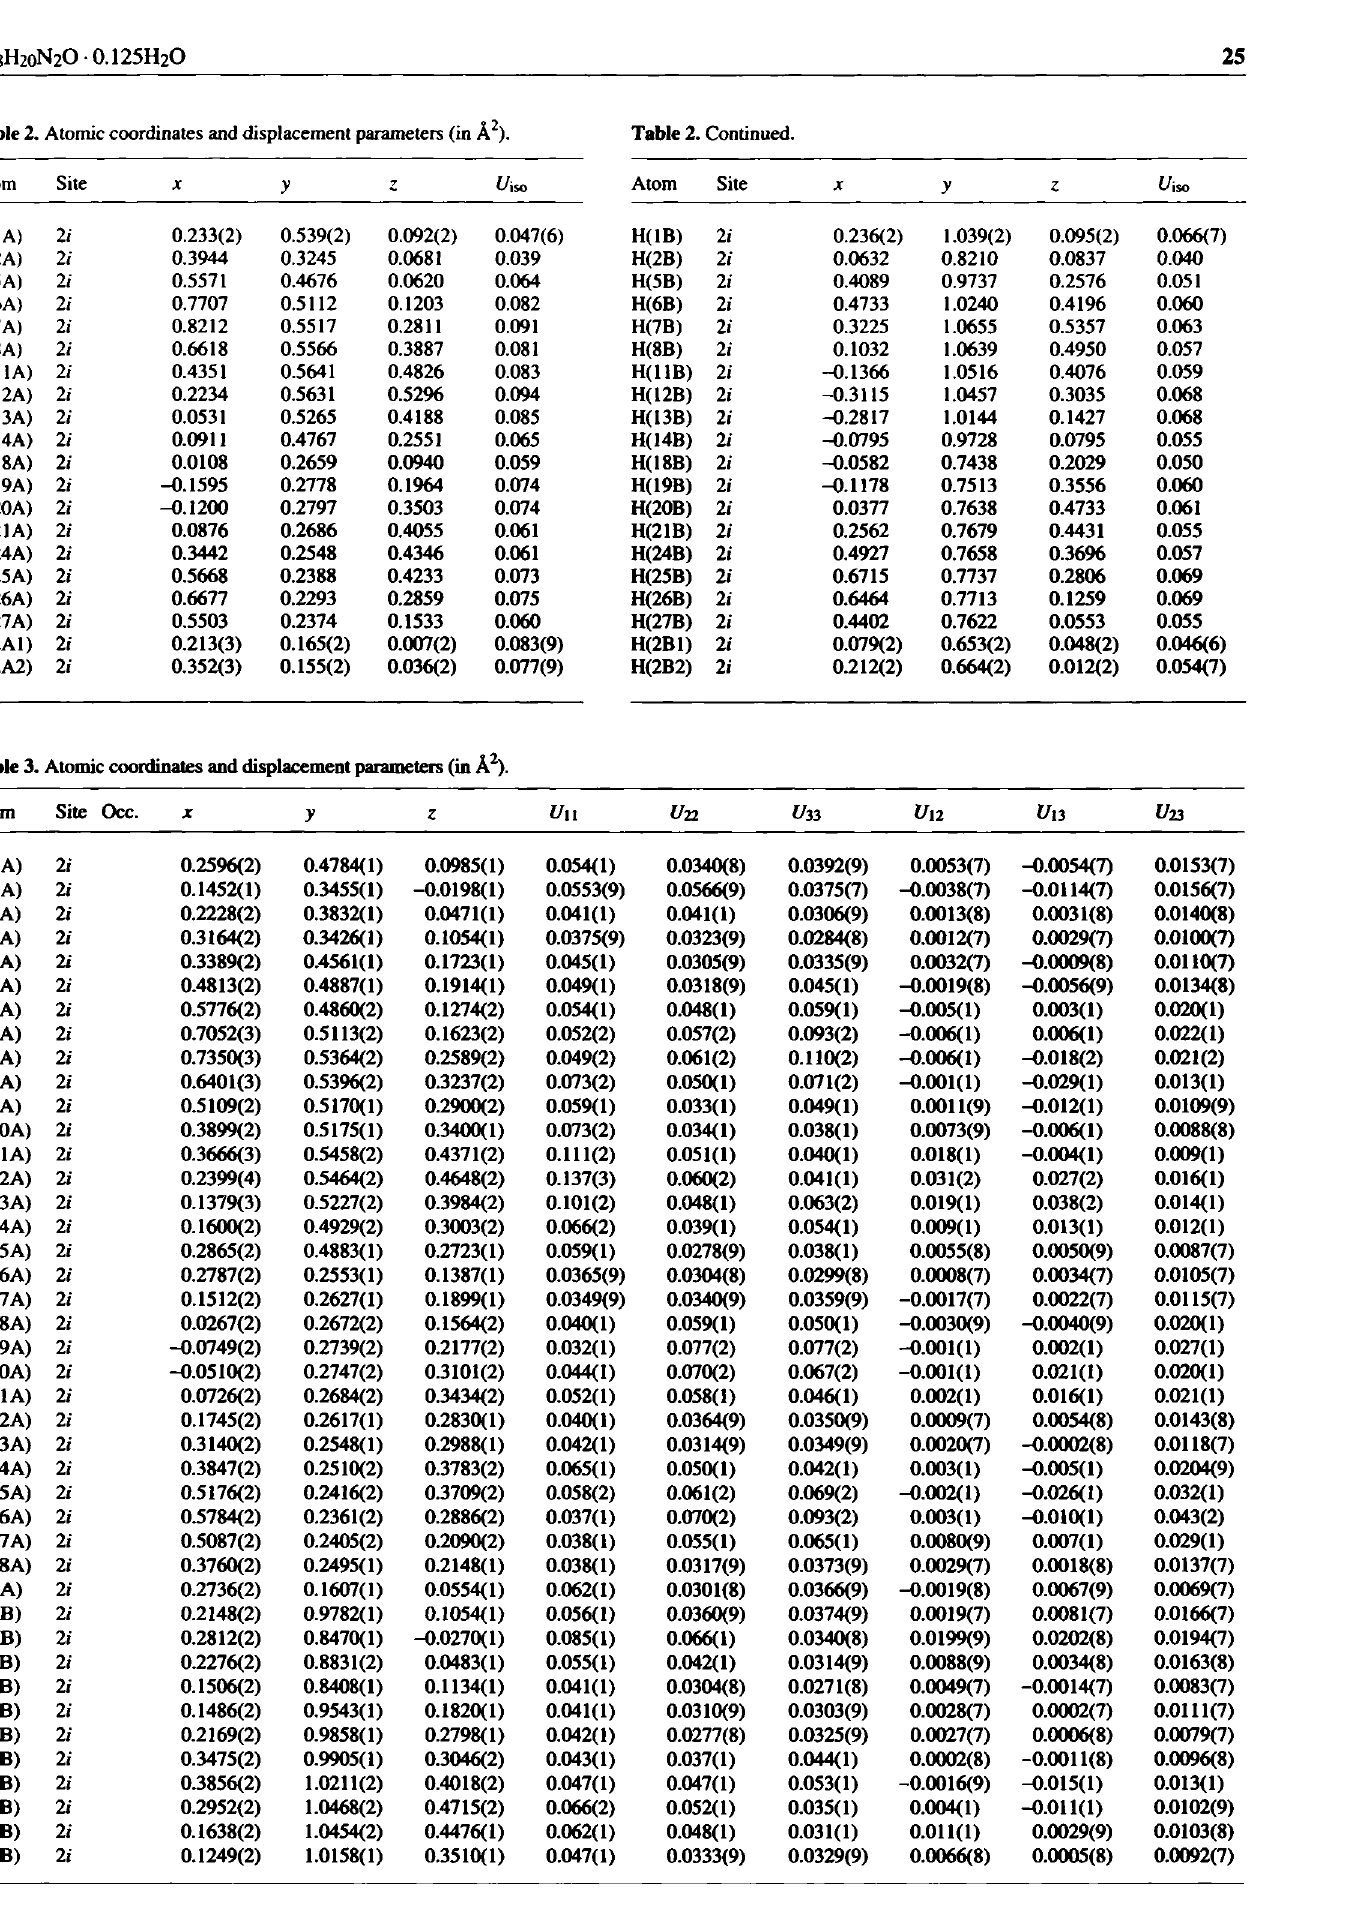
Table 2. Atomic coordinates and displacement parameters (in Â 2 ).